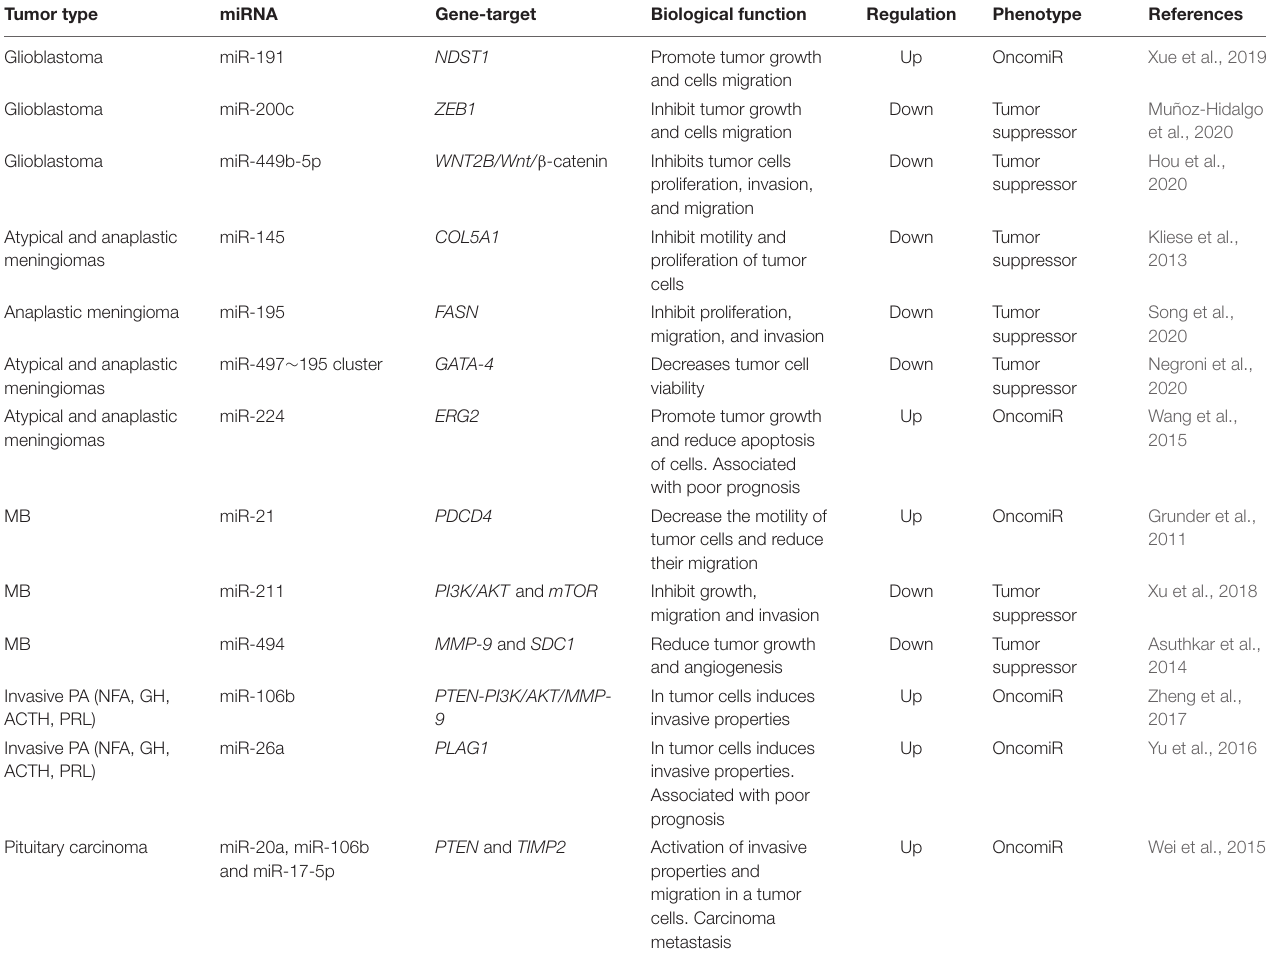
TABLE 1 | The most relevant studies to study the role of miRNAs in the oncogenesis of malignant primary brain tumors